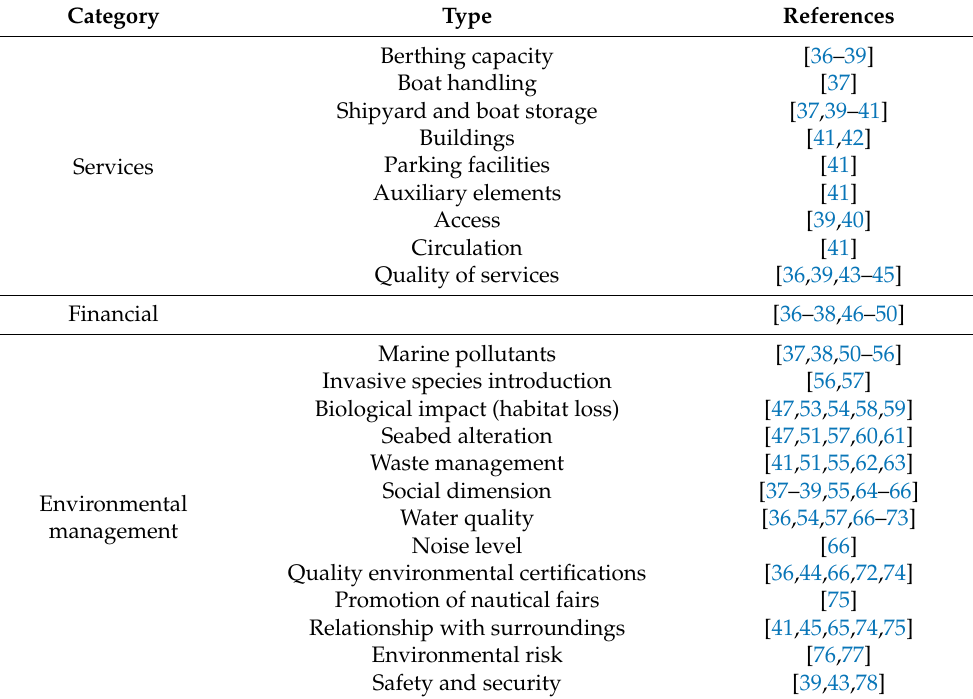
Table 2. Marina management’s review.